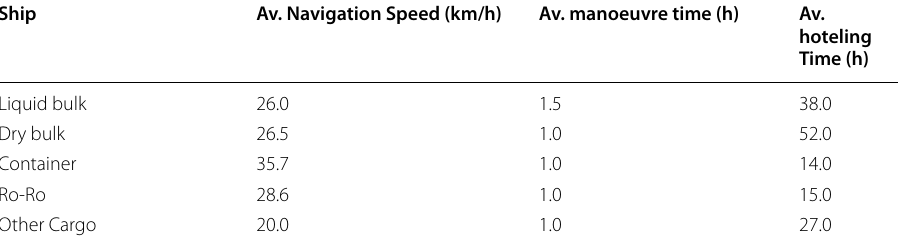
Table 3 Speed and times at node for different types of ships. Source Elaboration on Whall et al.